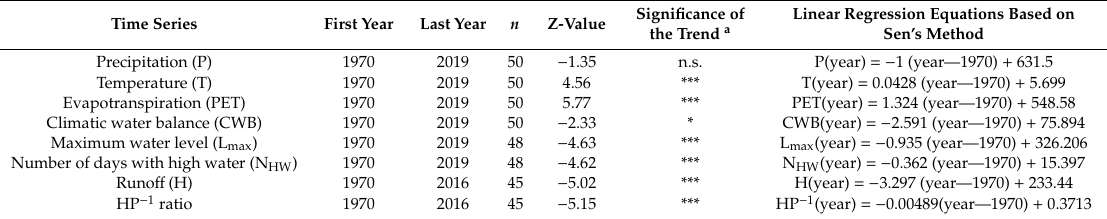
Table 1. Summary of the Mann–Kendall test and Sen’s slope estimation.